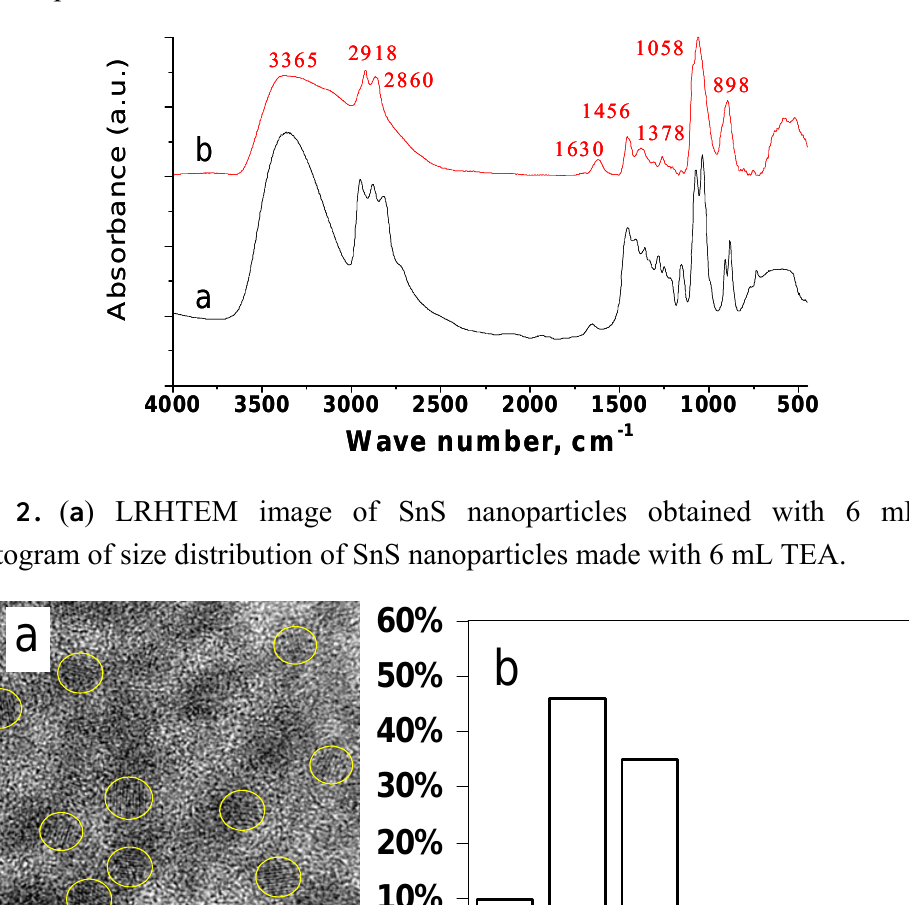
Figure 1. FT-IR spectra of ( a ) neat TEA and ( b ) TEA-capped SnS nanoparticles prepared at room temperature.